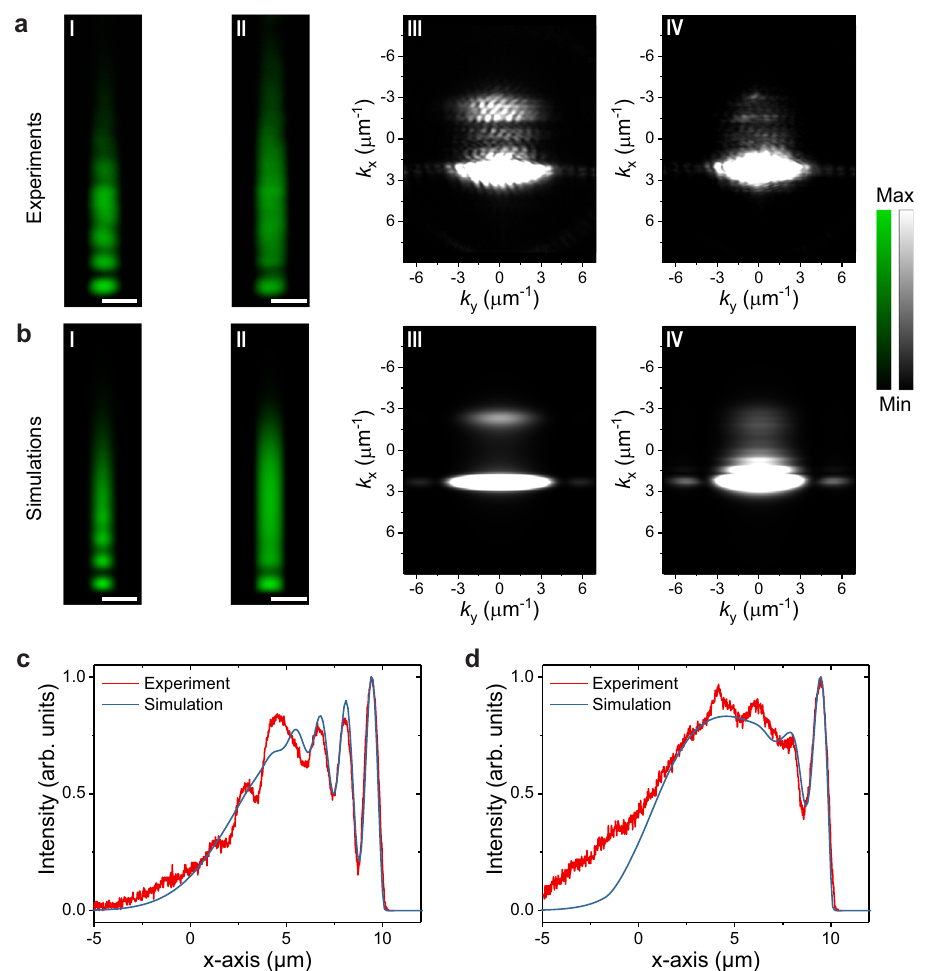
Fig. 2 | Room-temperature demonstration of one-dimensional polariton super fl uid transition. a -I, a -II Experimental real-space images of polariton fl uid with resonance pumping power in the cavity of 0.04 (I) and 3.8 (II) μ Jcm − 2 , respectively. The polariton fl uid with injection momentum of k || = 2.3 μ m − 1 fl ows along the microwire and is re fl ected by the edge, showing interference patterns in real-space ( a -I) at low polariton density. While at high polariton density, the polariton fl uid entered the super fl uid regime, and the interference pattern van- ished outside the healing length region. a -III, a -IV The experimental saturated images of momentum distributions correspondingto a -I and a -II,respectively. The back re fl ection signals were clearly observed at low polariton density and